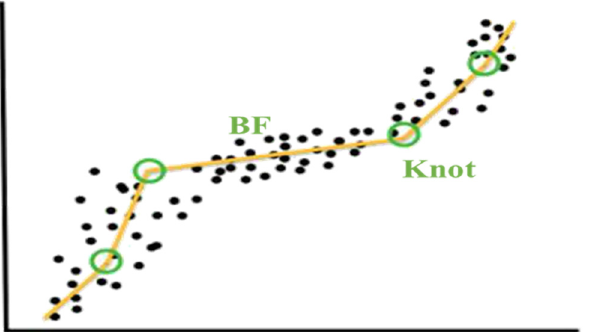
Figure 2. Multivariate adaptive regression splines (MARS). Dot means data samples ans line is its regression fitting.